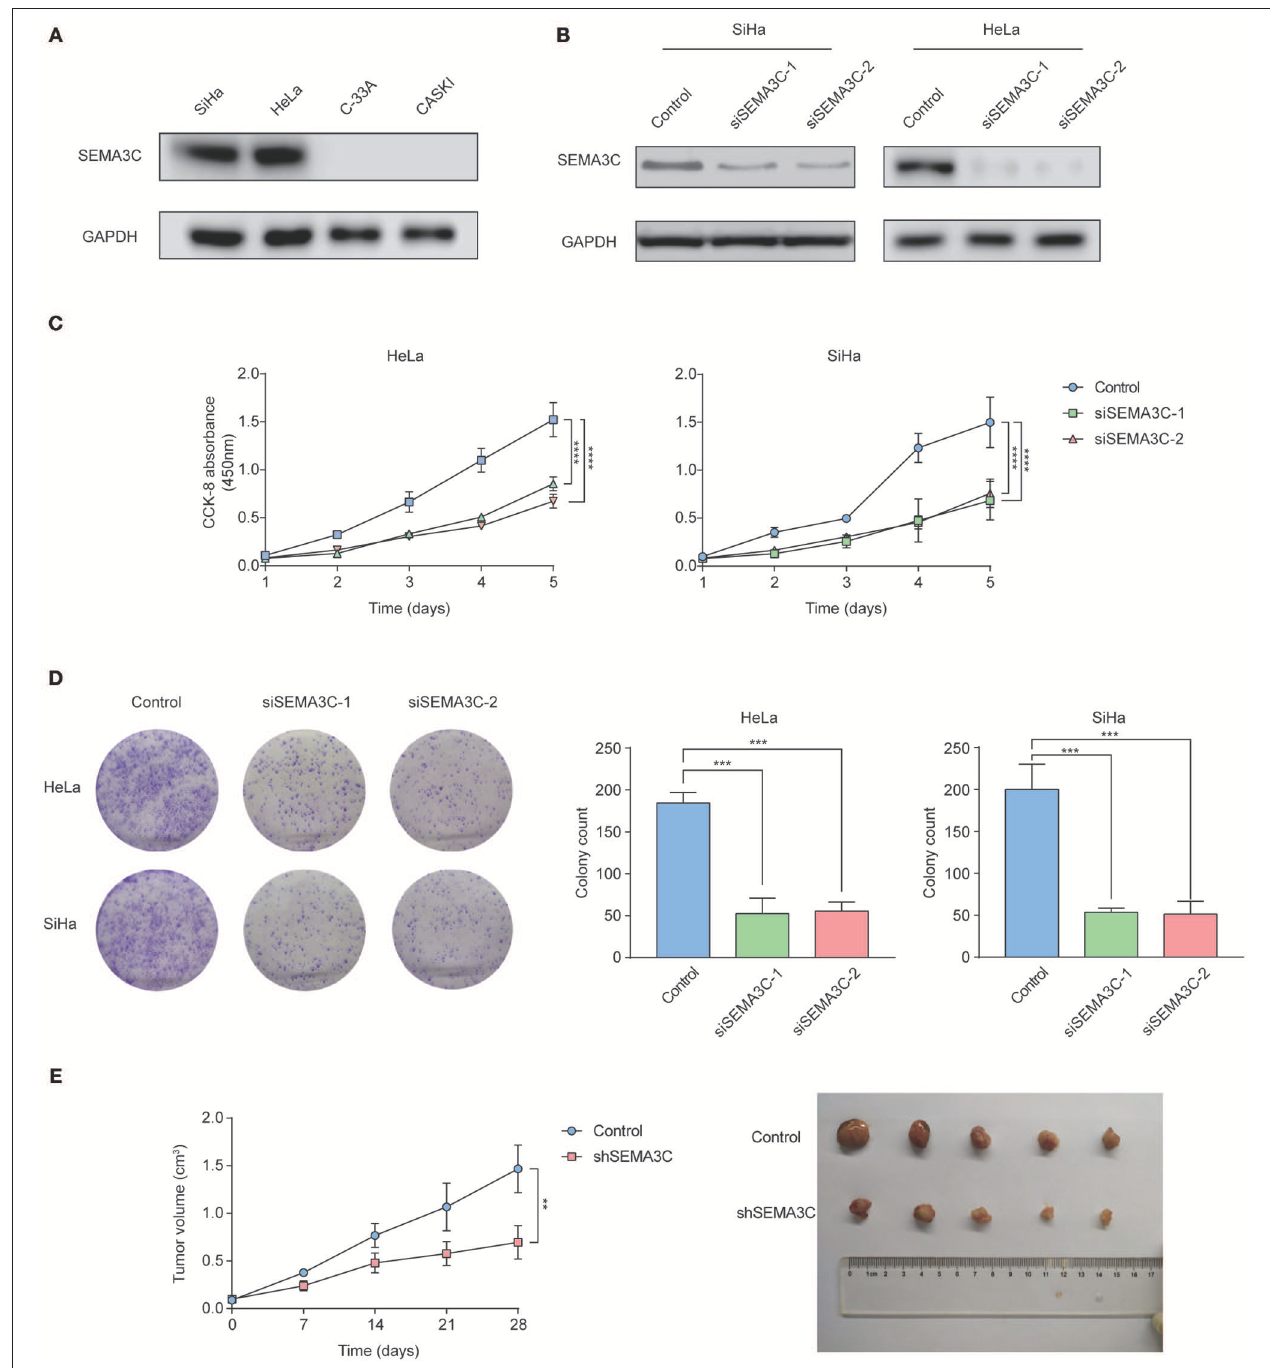
FIGURE 2 | SEMA3C promotes cervical cancer growth both in vitro and in vivo . (A) Western blotting analyses of SEMA3C expression in cervical cancer cell lines. (B) SEMA3C protein levels transfected with SEMA3C siRNA were determined by western blotting analysis. (C) Proliferation of silenced SEMA3C cells was evaluated by CCK-8 assays. Data represent the mean ( ± SD) of three independent experiments, each performed in silenced SEMA3C HeLa and SiHa cells, compared with the control. Error bars indicate S.D. (** p < 0.01; *** p < 0.001). (D) Silencing SEMA3C inhibited HeLa and SiHa cell colony formation. Data represent the mean ( ± SD) of three independent experiments, each performed in silenced SEMA3C HeLa and SiHa cells, compared with the control. Error bars indicate S.D. (** p < 0.01; *** p < 0.001). (E) SiHa shSEMA3C or control cells were subcutaneously injected into nude mice for xenograft assay. Tumor growth curve and average weight in each group are shown. Data represent the mean ( ± SD) of five mice. Error bars indicate S.D. (** p < 0.01; *** p < 0.001).